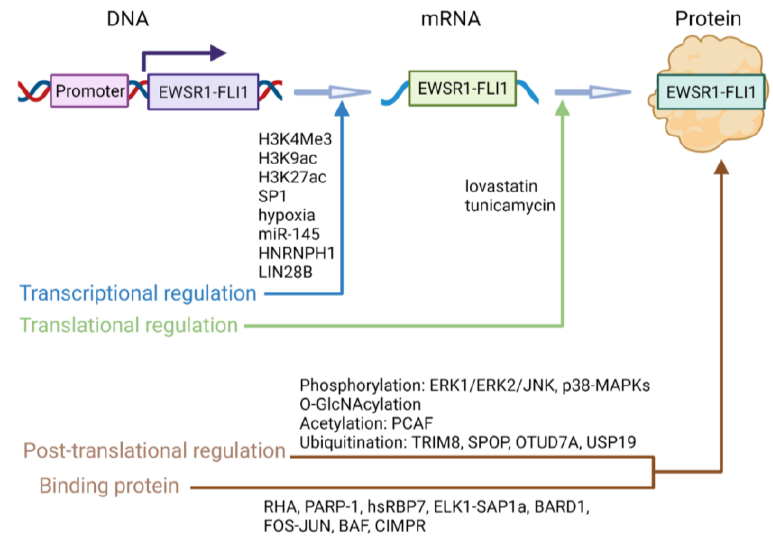
Figure 1. Regulatory mechanisms controlling EWSR1::FLI1. Proper EWSR1::FLI1 protein expression is controlled by multi-layer mechanisms, including regulation of transcription by epigenetic regulations, transcription factors and miRNA/lncRNAs, translational regulations, post-translational regulation and various binding proteins. This figure is generated using BioRender.